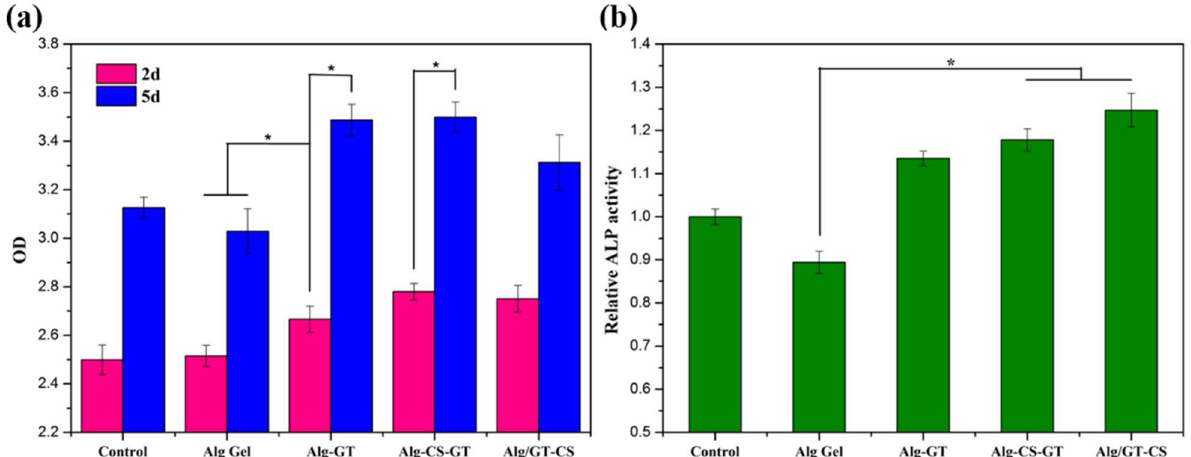
Figure 8. ( a ) Cell proliferation viability of MC3T3-E1 cells cultured on the Alg Gel, Alg-GT, Alg-CS- GT and Alg/GT-CS for 2 d and 5 d; ( b ) Cell differentiation of MC3T3-E1 cells on the Alg Gel, Alg-GT, Alg-CS-GT and Alg/GT-CS for 7 d. *represents p < 0.05, indicating highly significant difference.